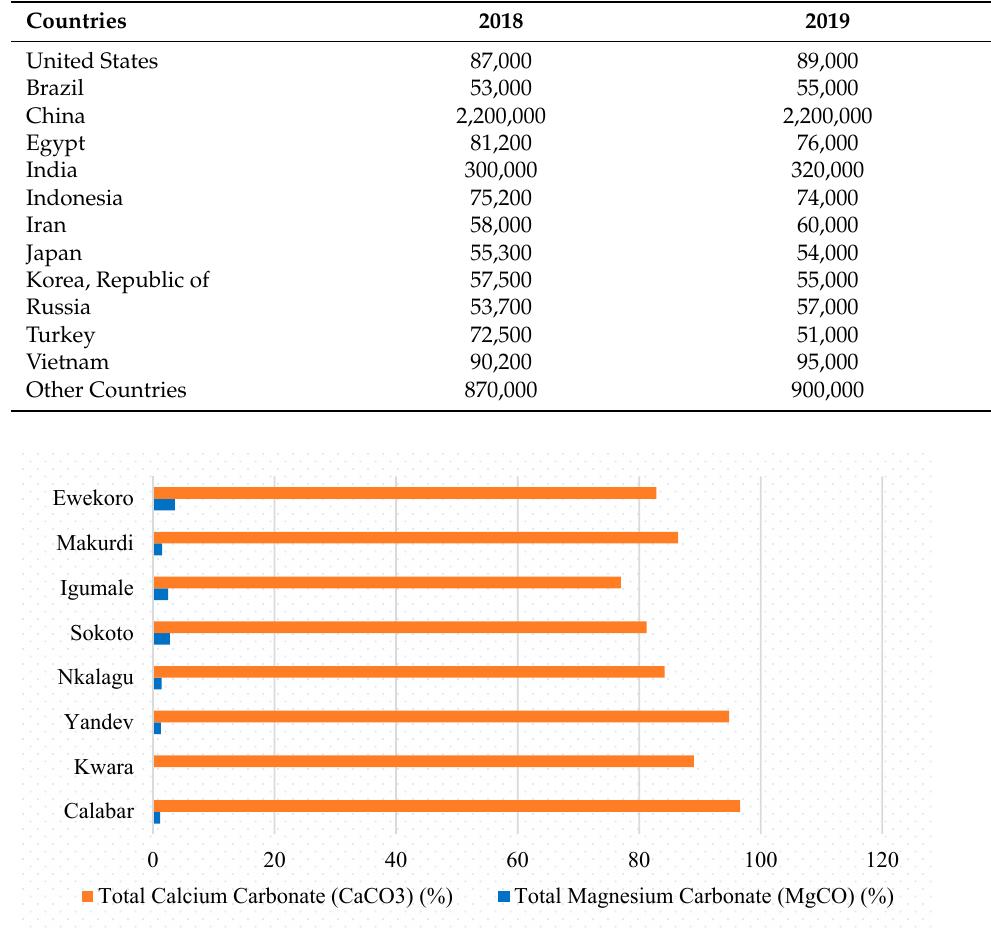
Figure 1. Percentage quantity of calcium carbonate and magnesium carbonate in Nigerian Limestone Deposit [9,10].